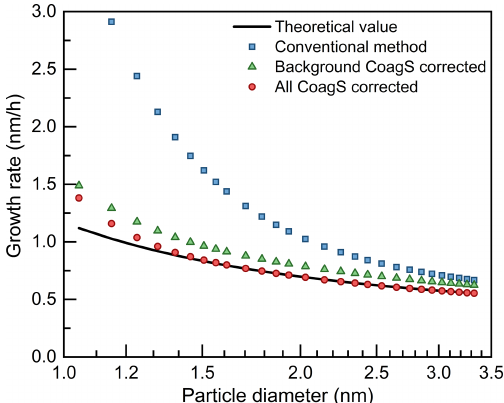
Figure 4. The impact of coagulation sink (CoagS) due to colliding with a smaller particle on the appearance time method. Only the coagulation with a larger particle is accounted for in the correction using the background